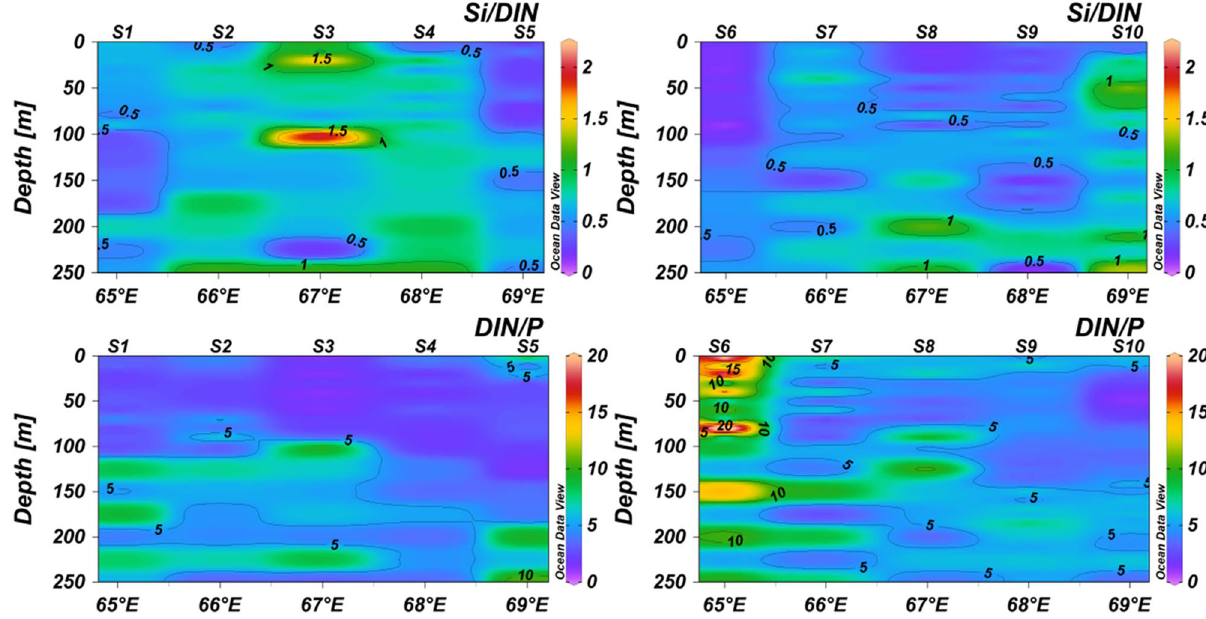
Figure 3. Vertical sections of Si/DIN and DIN/P along 21°N and 20°N transects. DIN includes nitrate, nitrite and ammonium. Plot created in ODV 57